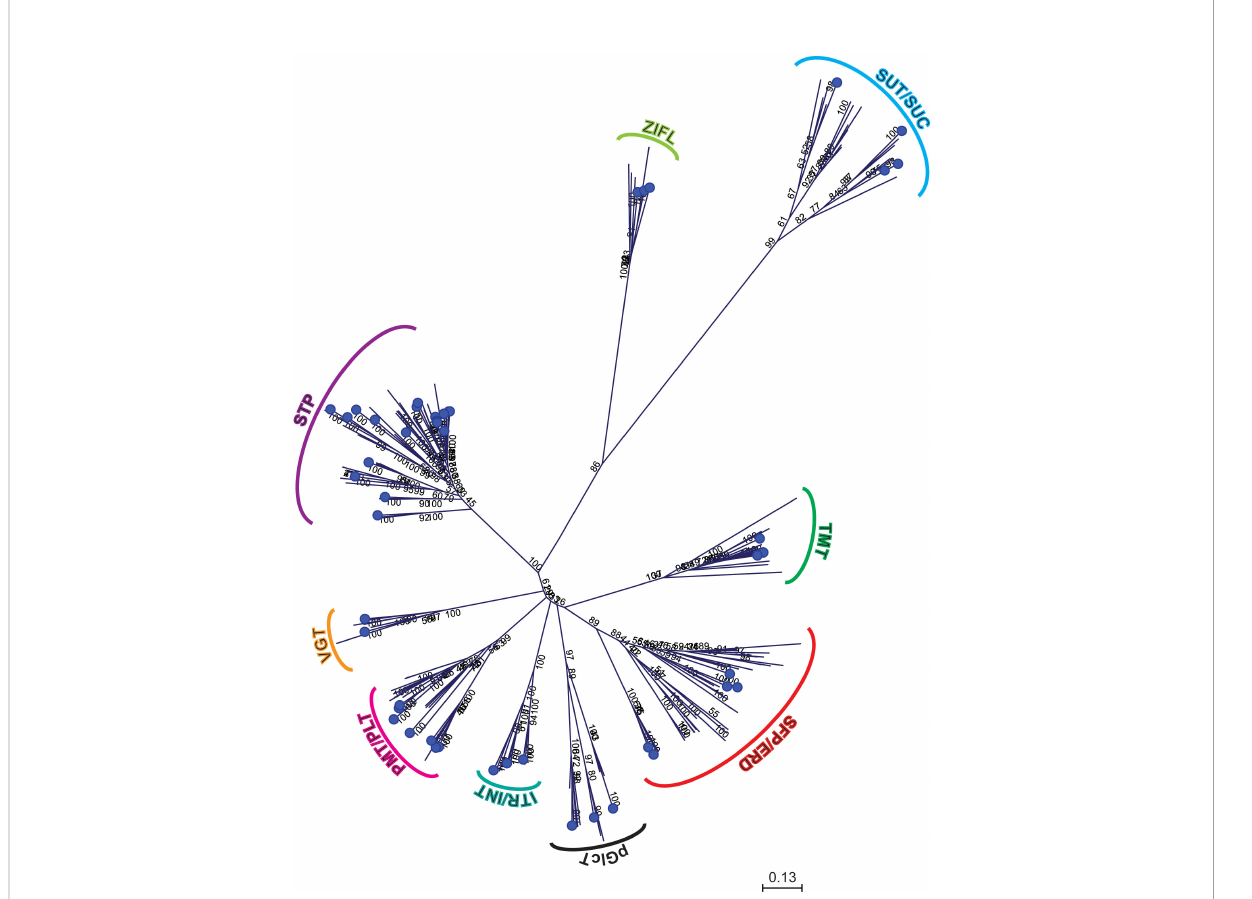
FIGURE 4 Phylogeneticrelationshipofsugartransportersamongrepresentativemonocotyledonsanddicotyledons.Theproteinsequenceswereusedtobuildthe